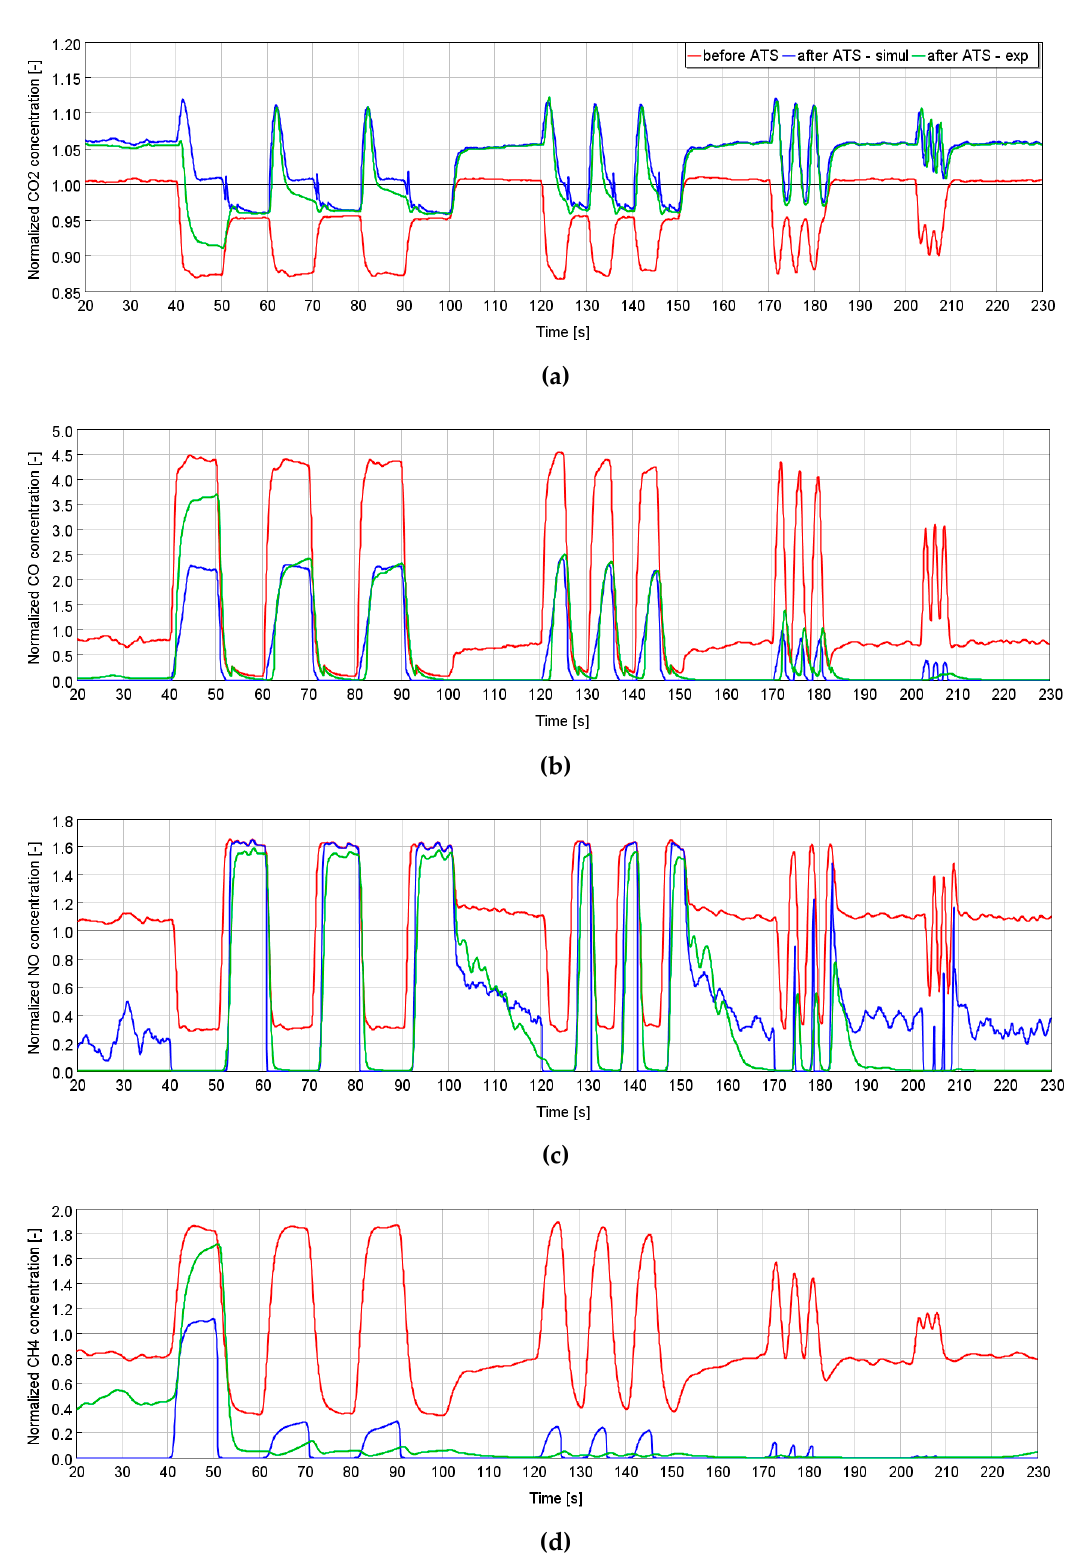
Figure 10. Transient conditions at 100% Load. Gas Temperature ≈ 750 ◦ C ( a ) Num / Exp. CO 2 engine out and tailpipe concentration. ( b ) Num / Exp. CO engine out and tailpipe concentration. ( c ) Num / Exp. NO engine out and tailpipe concentration ( d ) Num / Exp. CH 4 engine out and tailpipe concentration.